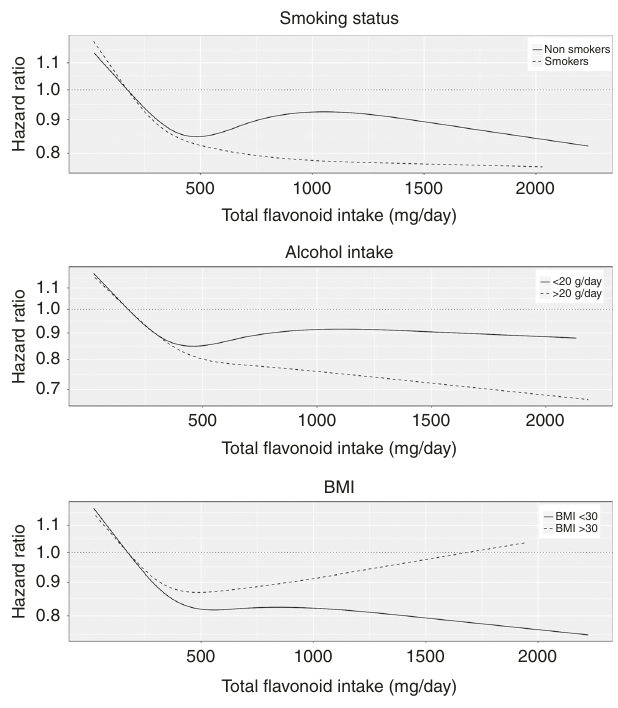
Fig. 3 The association of total fl avonoid intake with all-cause mortality, strati fi ed by risk factors. Multivariable-adjusted association between total fl avonoid intake and all-cause mortality strati fi ed by current smoking status, alcohol intake and BMI. Values are hazards ratios and 95% CI for the highest compared to the lowest quintiles of intake. All analyses were